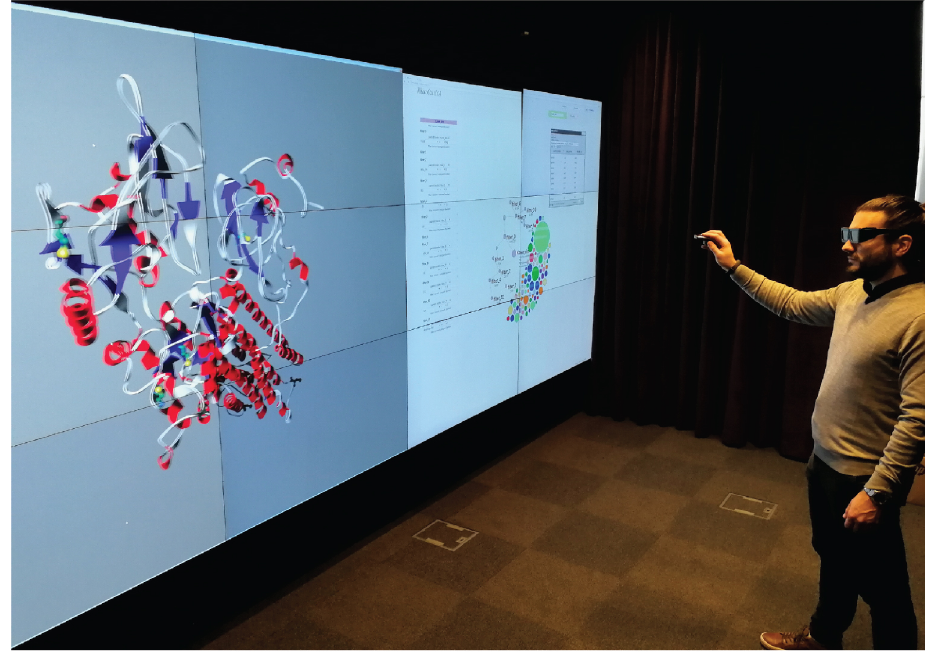
Figure 8: Split-screen setup with stereoscopy. Example of MinOmics running on a web browser on the right half of the display wall, linked to a 3D stereoscopic rendering via UnityMol filling the left half. A gyroscopic mouse is used to oper- ate the system and interact with all